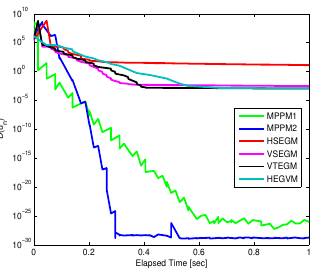
Figure 3. Methods for Example 1 with α n = ( n + 1) − 0 . 5 . Number of iterations is 82, 95, 181, 263, 348, 387,